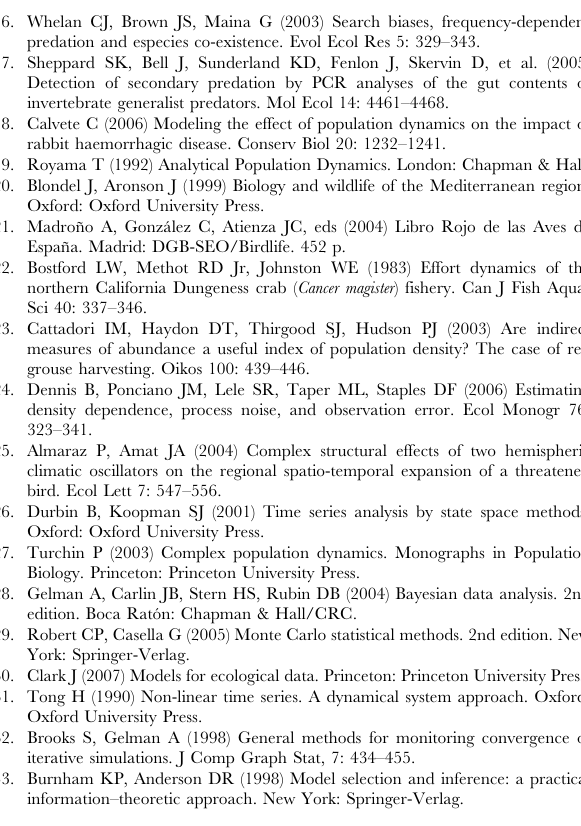
Figure S1 The Monte Carlo trace of the three Markov Chains (shown in green, red and blue) is shown for each parameter in the state-space model selected as the most parsimonious by the BIC, for both the European rabbit (a) and the red-legged partridge (c). Each chain was initiated with slightly different parameter values. Also shown are the probability density kernels of each parameter, constructed after joining the three chains. The autocorrelation plot is shown for each chain after thinning the MCMC samples every 20 iterations, for both the European rabbit (b) and the